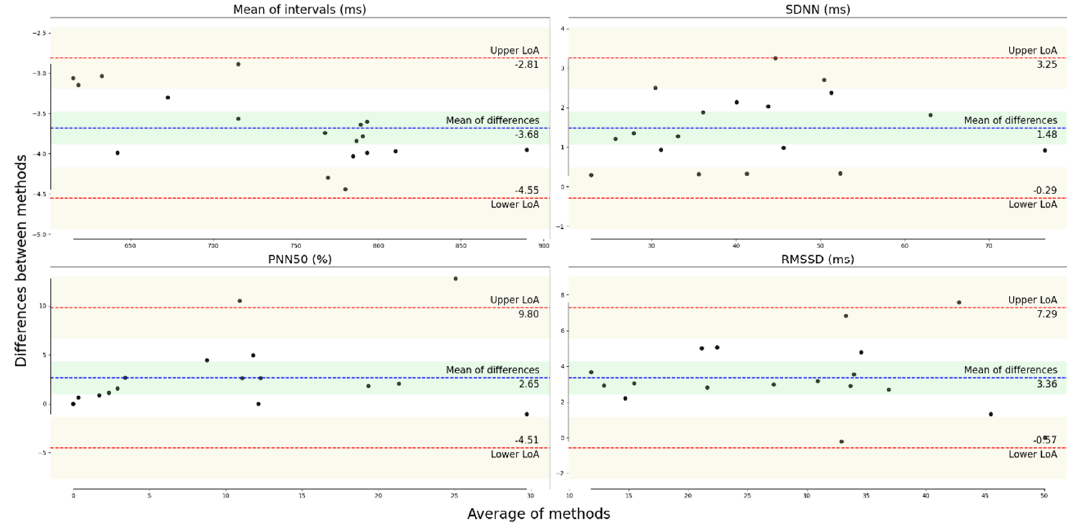
Figure A3. Bland–Altman plots for the pairs of time-domain metrics obtained during the SCWT. The blue line and area represent the mean of the differences between measurements and the associated confidence interval. The red lines and the associated area represent the upper and lower LoA and the associated confidence intervals.